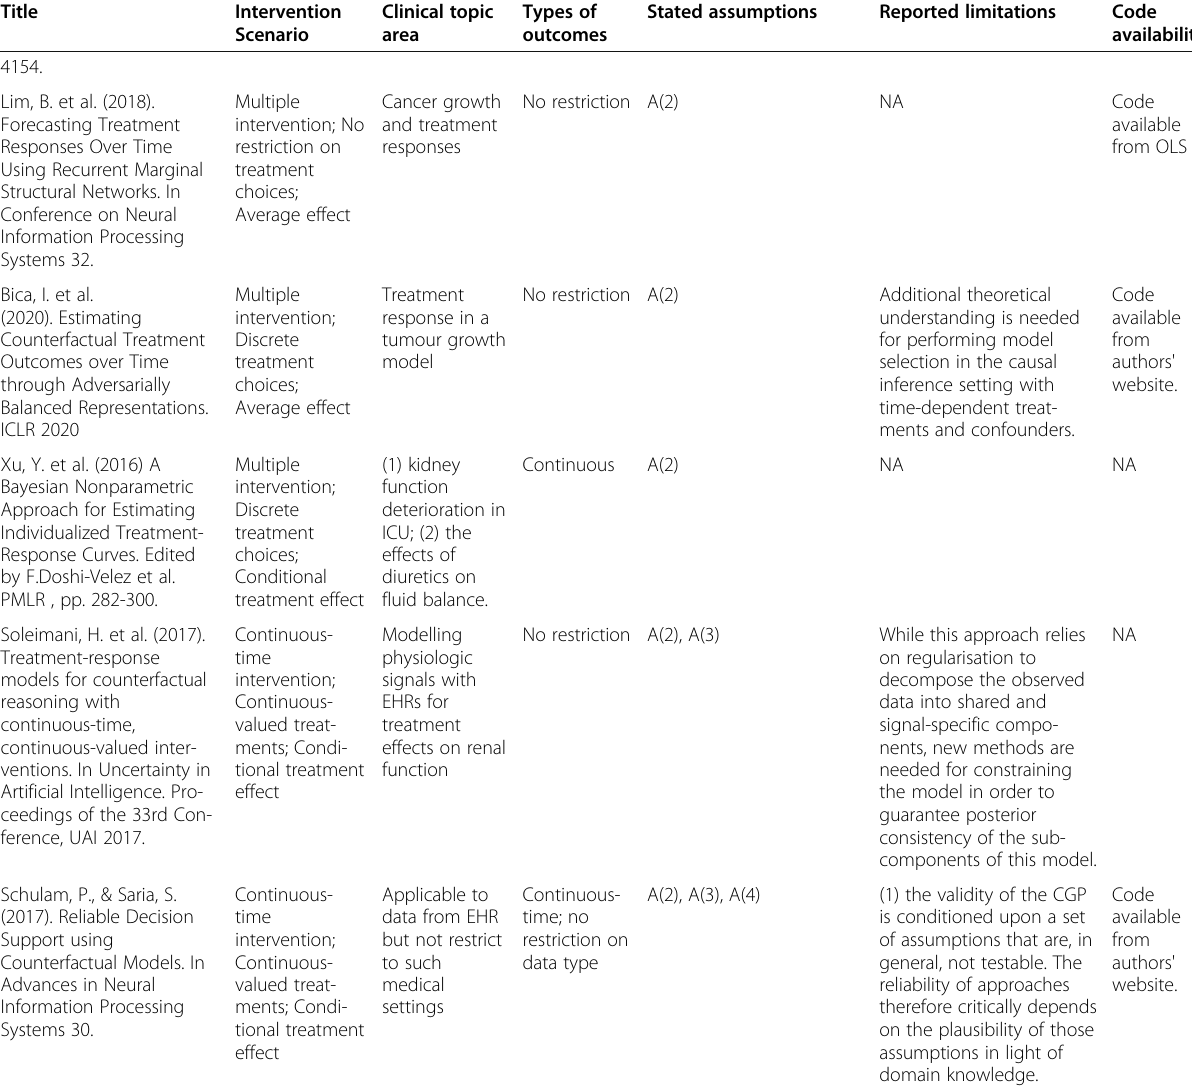
Table 1 Summary of included 13 papers (See Supplementary File 1 for the completed extraction table)